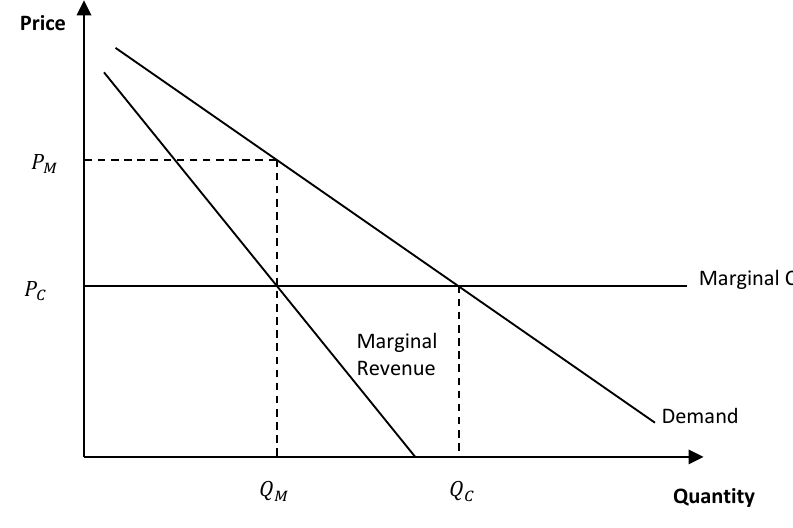
FIGURE 2: Output restriction under monopoly Source: Derived from economic first